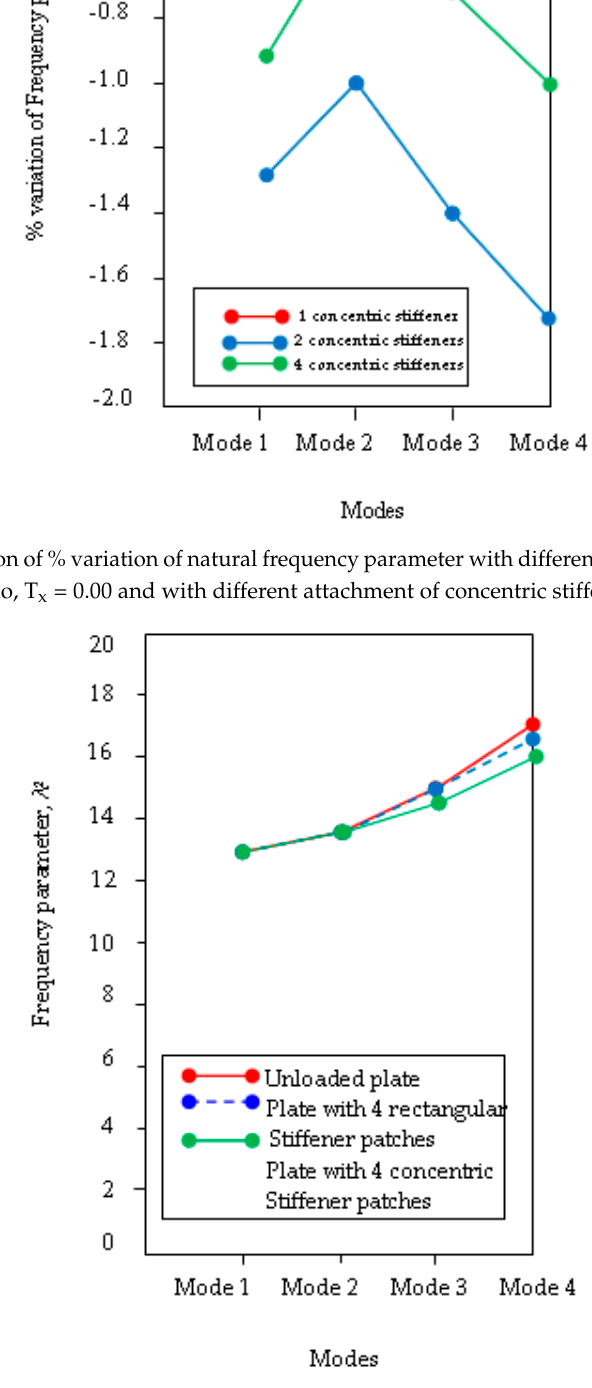
Figure 7. Comparison of variation of different frequency parameter with different modes for an unloaded plate and for a plate with 4 rectangular and 4 concentric stiffener patches.